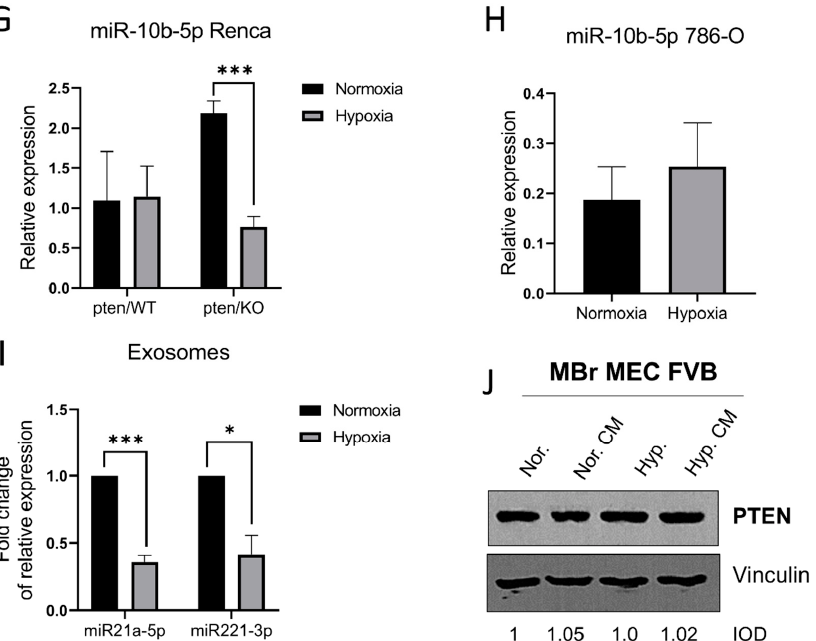
Figure 4. PTEN-related miRNAs in hypoxic conditions ( A ) PTEN detection by western blot in Renca pten/WT cells cultured in normoxic and hypoxic condition, IOD calculated relative to Vinculin ( B ) Relative to miR-25-3p and miR-16-5p expression of miR-21a-5p and ( C ) miR-221-3p in Renca pten/WT and pten/KO cells cultured in normoxia and hypoxia ( D ) PTEN detection by western blot in Caki-1 cells cultured in normoxic and hypoxic condition, IOD calculated relative to Vinculin ( E ) Relative to miR-25-3p and miR-16-5p expression of miR-221-3p in Caki-1 cells, and ( F ) in 786-O cells cultured in normoxia and hypoxia ( G ) Relative to miR-25-3p and miR-16-5p expression of miR-10b-5p in Renca pten/WT and pten/KO cells and ( H ) 786-O cells cultured in normoxia and hypoxia ( I ) Fold change of relative to miR-25-3p and miR-16-5p expression of miR-21a-5p and miR- 221-3p in exosomes isolated from Renca pten/WT cells cultured in normoxia and hypoxia ( J ) PTEN detection by western blot in MBr MEC FVB cells cultured in normoxic and hypoxic condition with or without conditioned medium (CM) from Renca pten/WT cells, IOD calculated relative to Vinculin, Student’s t test *** p -value < 0.001; ** p -value < 0.01; * p -value <